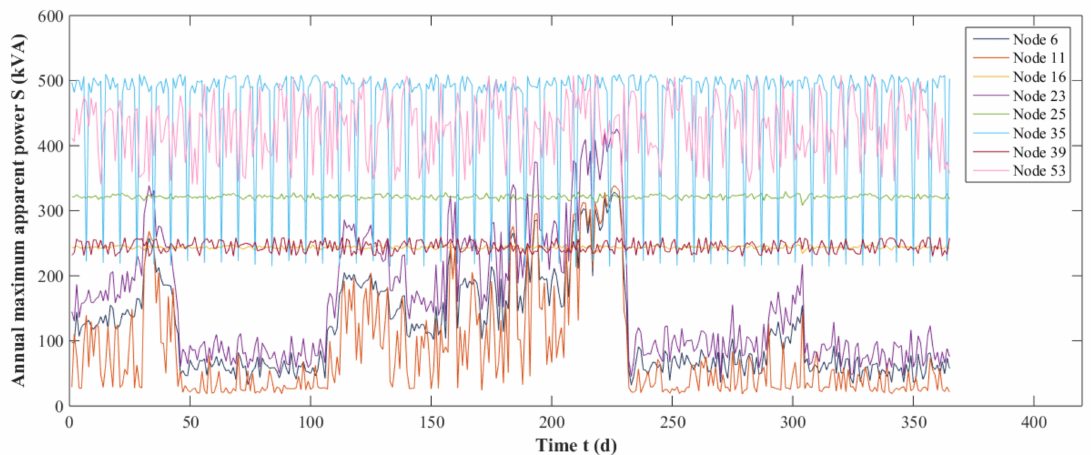
Figure 5. Annual maximum apparent power curves at eight electric energy replacement points in the first year of electric energy replacement.